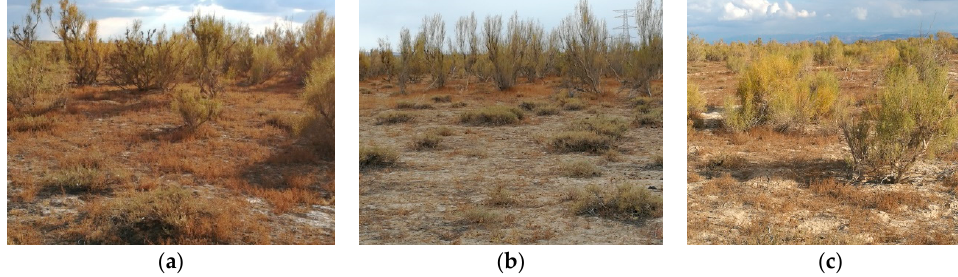
Figure 11. Sampling environment for Area A: ( a ) environment one; ( b ) environment two; and ( c ) environment three.